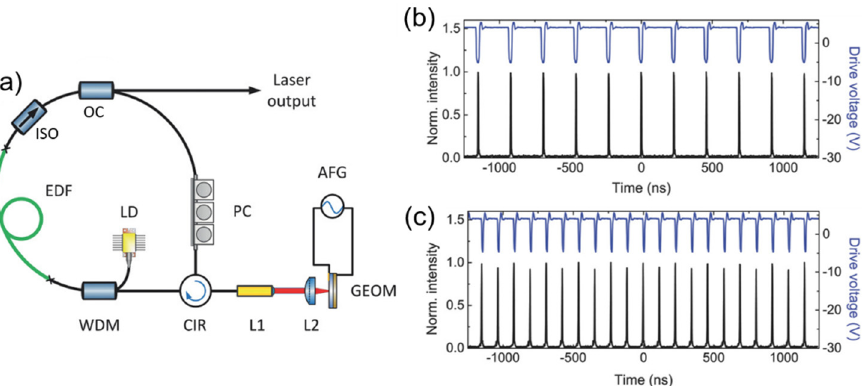
Figure 11. Graphene electro-optic modulator (GEOM) controlled mode-locked ultrafast fiber laser. ( a ) Laser cavity setup. EDF: erbium doped fiber; LD: laser diode; WDM: wavelength-division mul-